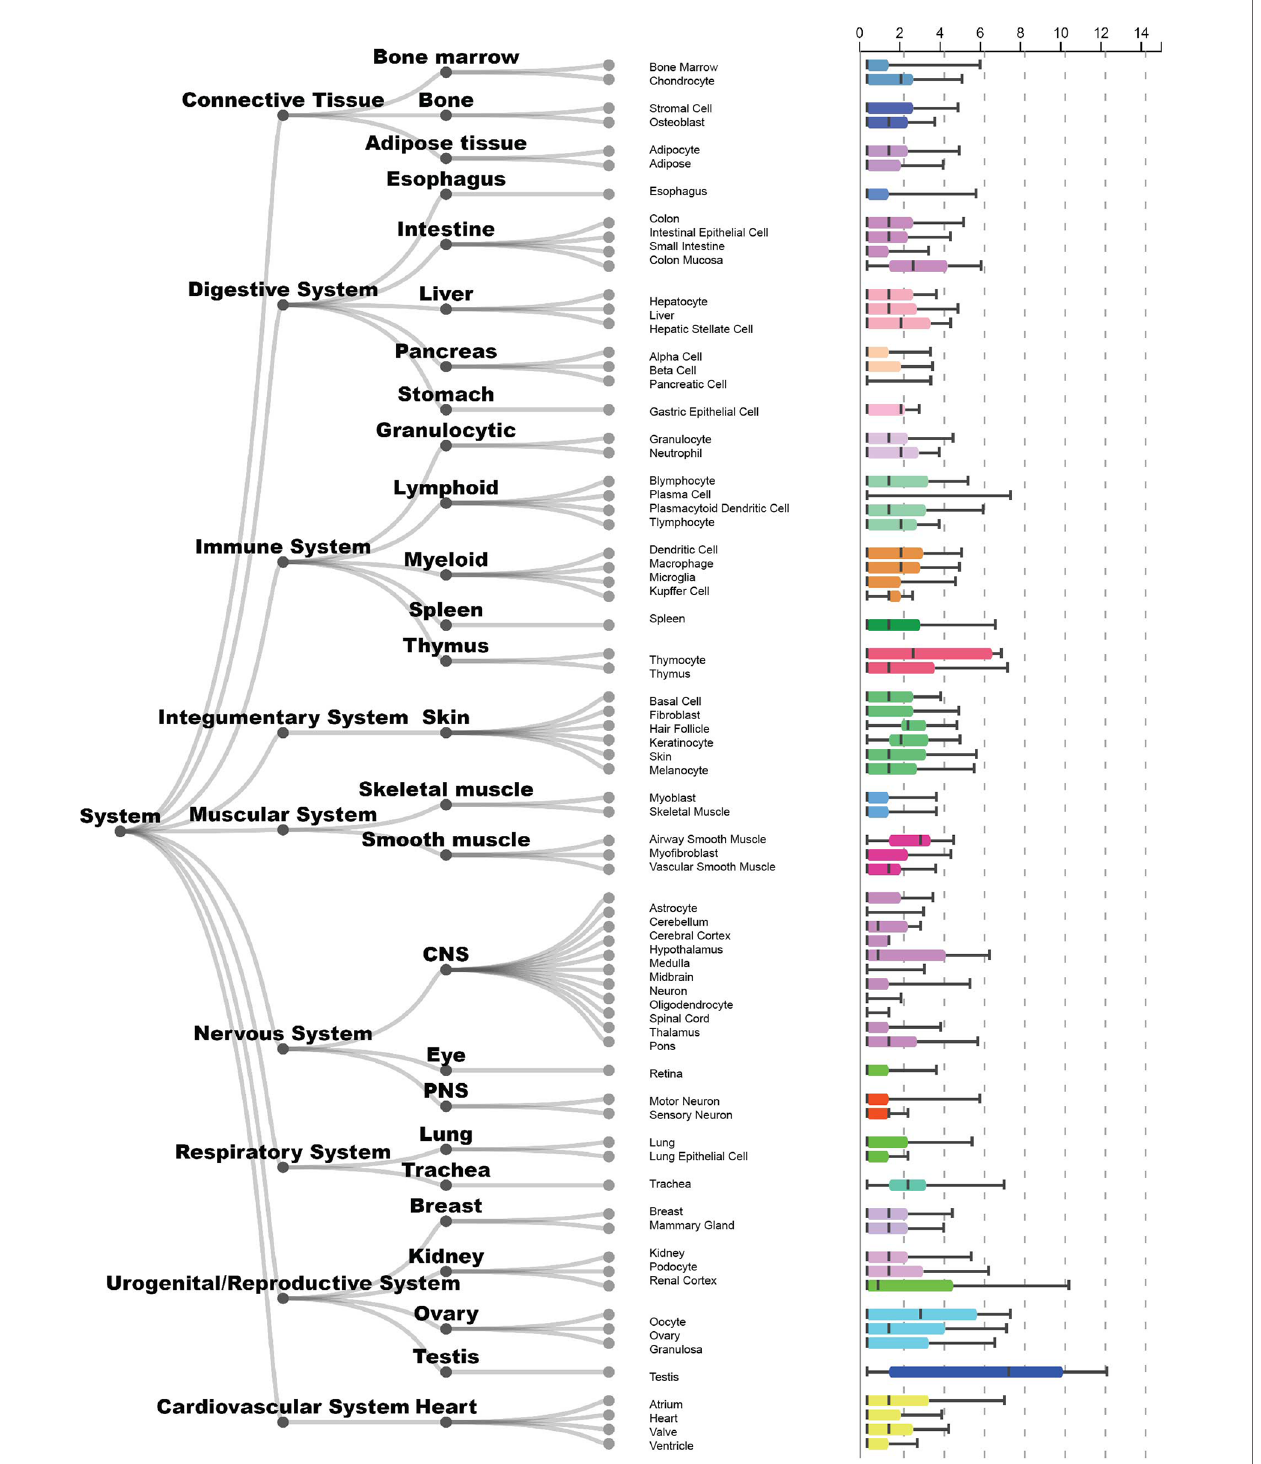
FIGURE 1 | Tissue expression of the gene TEX101 in humans (categorised by system). This fi gure was constructed and modi fi ed from the ARCHS 4 database, where expression levels are mined from publicly available data, and can be downloaded by any users. Samples come from many different sources and various subtypes cannot be mixed. Gene expression is normalised across different tissues and given as log transformed counts. Tissues are grouped into levels and cover most cellular contexts. This shows the variability of gene expression in non-homogeneous sample groups. Further information can be found at the TEX101 – ARCHS4 database entry (ARCHS4, n.d.)